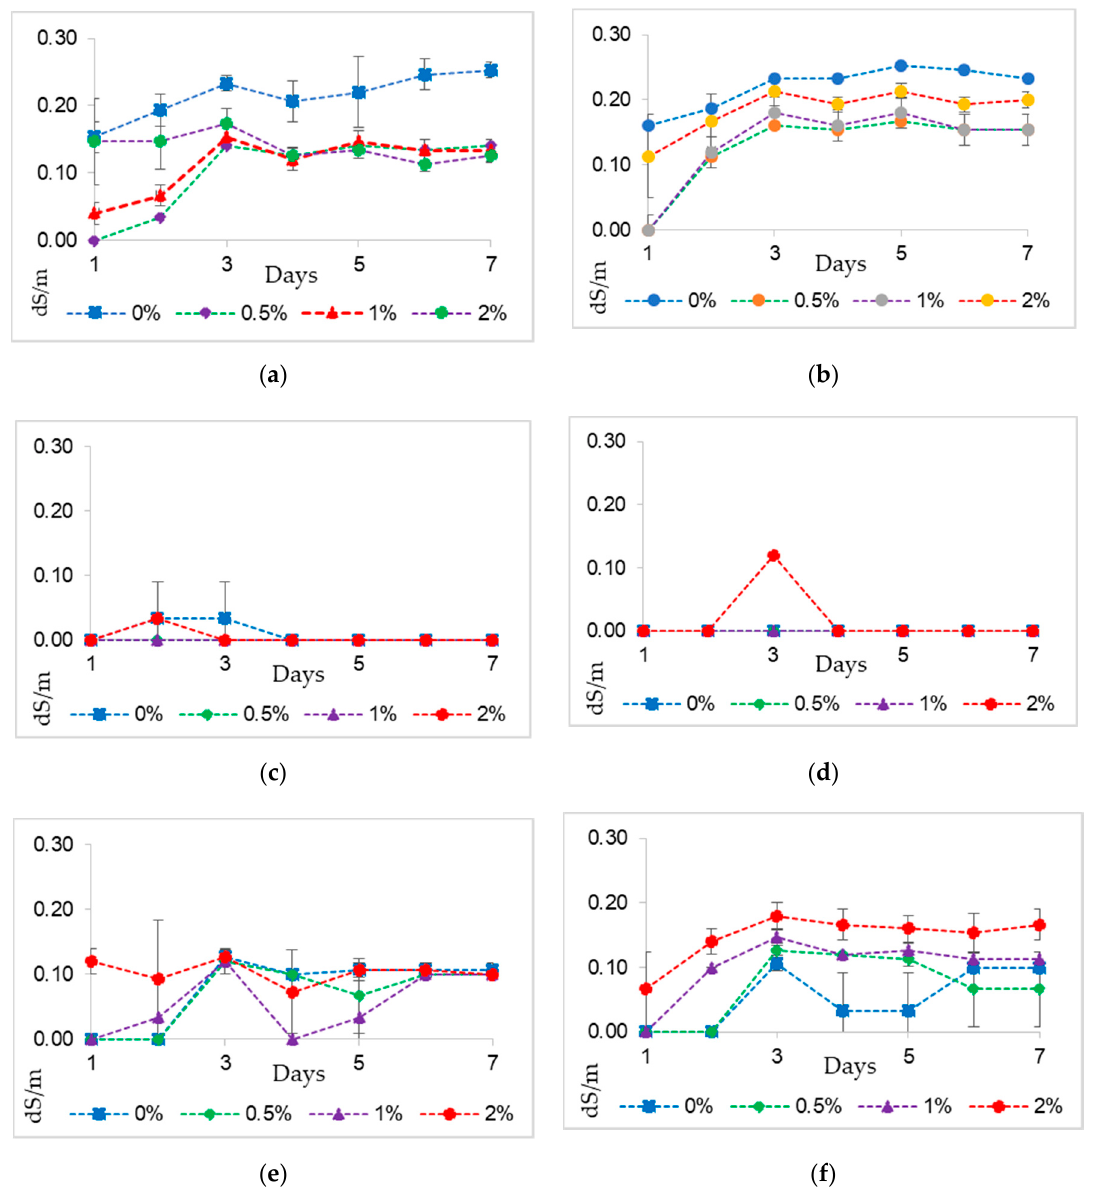
Figure 8. Temporal effect of biochar on electrical conductivity (EC): ( a ) topsoil with granular biochar; ( b ) topsoil with powder biochar; ( c ) E-horizon soil with granular biochar; ( d ) E-horizon soil with powder biochar; ( e ) mixed soil with granular biochar; ( f ) mixed soil with powder biochar.